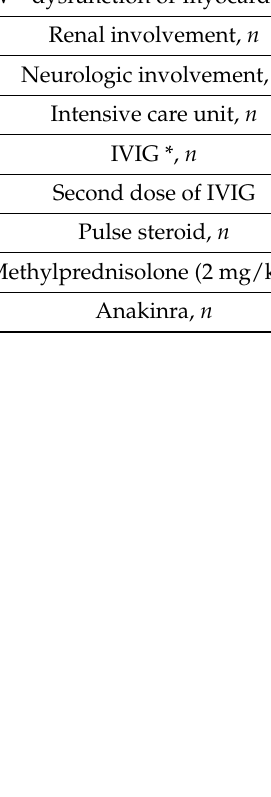
Table 3. Comparison of laboratory findings of